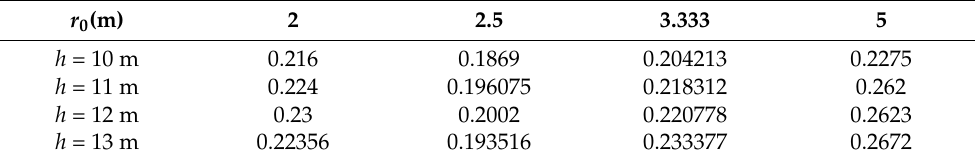
Table 4. Error ( ε / d ) analysis for different tetrahedron (4 ANs) heights h and transmission ranges r 0 . r 0